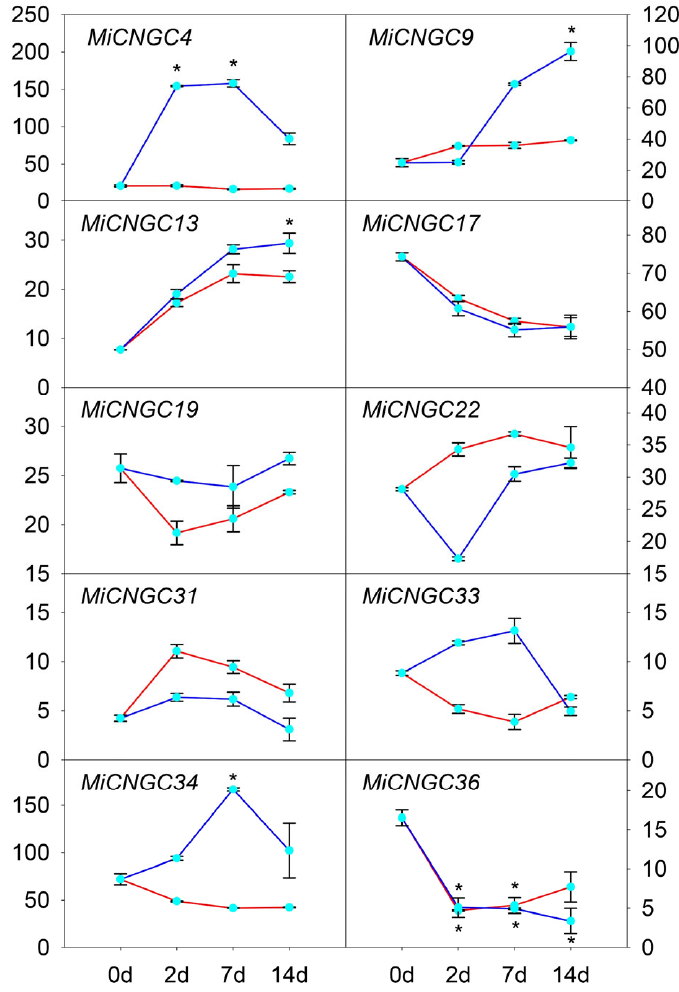
Figure 4. In silico expression of CNGC genes under cold stress of (blue) and 12 °C (red) in mango fruit peel. The x ‐ axis represents the samples collected at 0, 2, 7 and 14 days after treatment. The y ‐ axis represents FPKM values. The error bar represents the standard error. * represents that the expression level was up or downregulated over 3 ‐ fold.